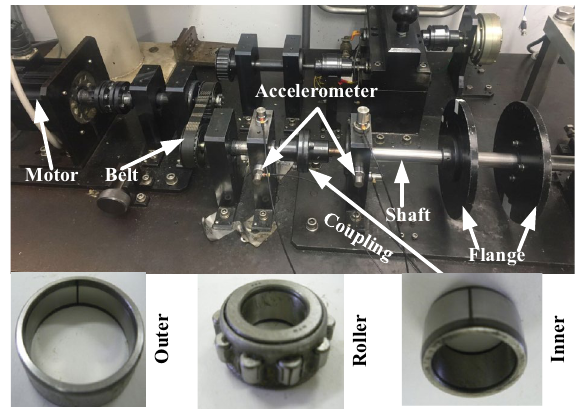
Figure 11. Mechanical setup of industrial process.